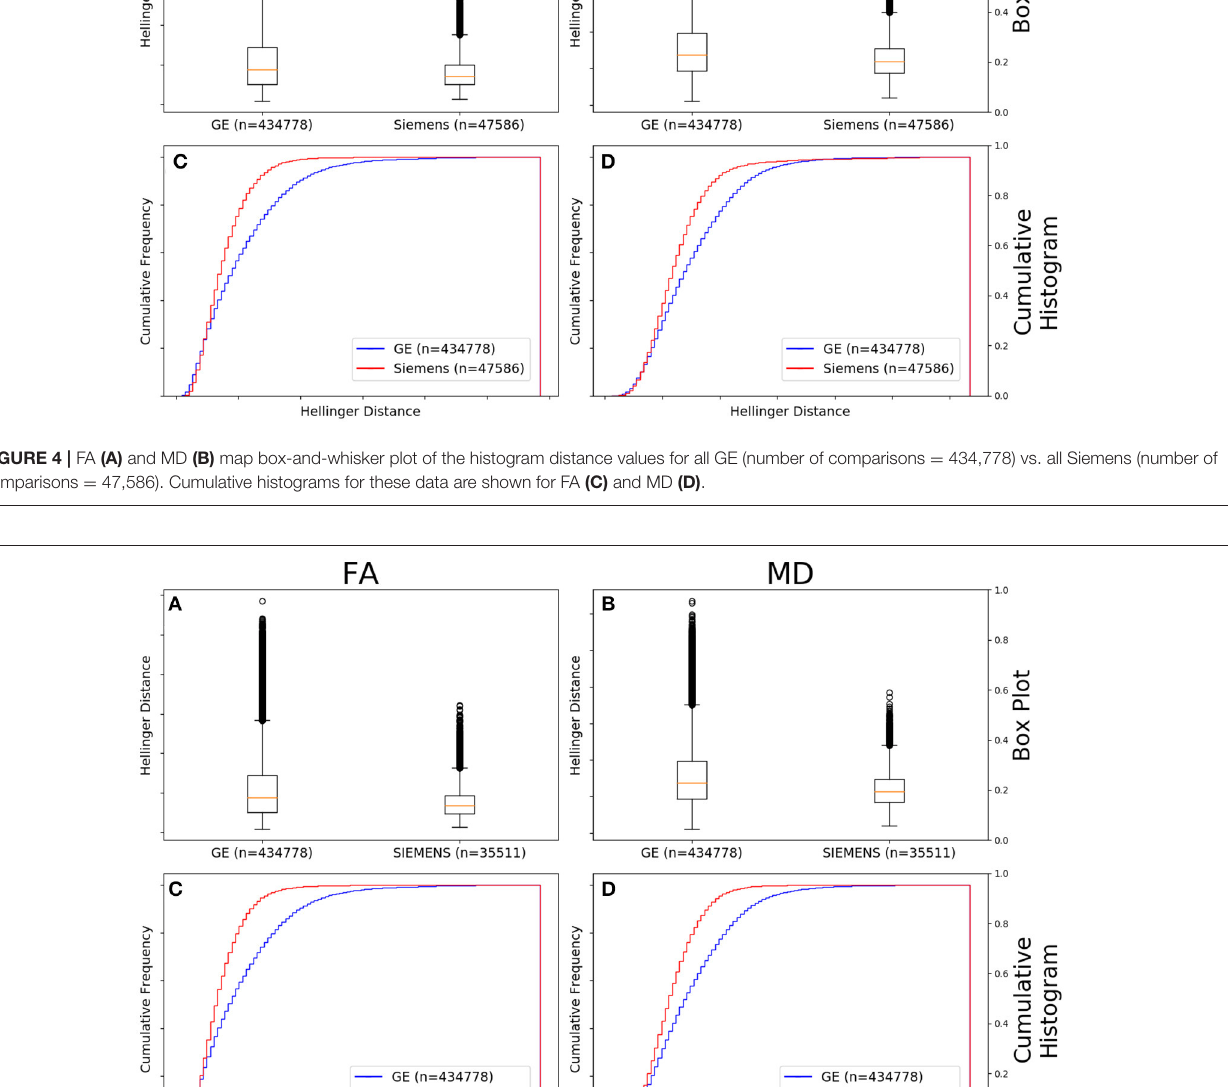
upper limit, excluding outliers, was 0.2168 for the 3.0T group